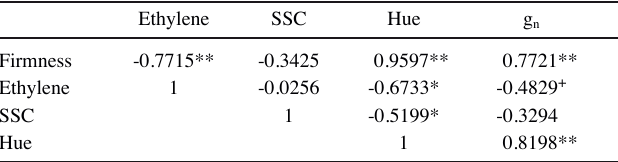
Tab. 3: Correlation between measured parameters